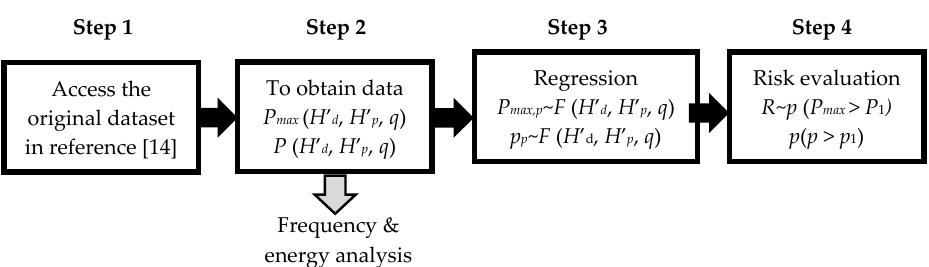
Figure 3. Development of risk index R for pathogen transmission risk in a contaminated drainage stack.